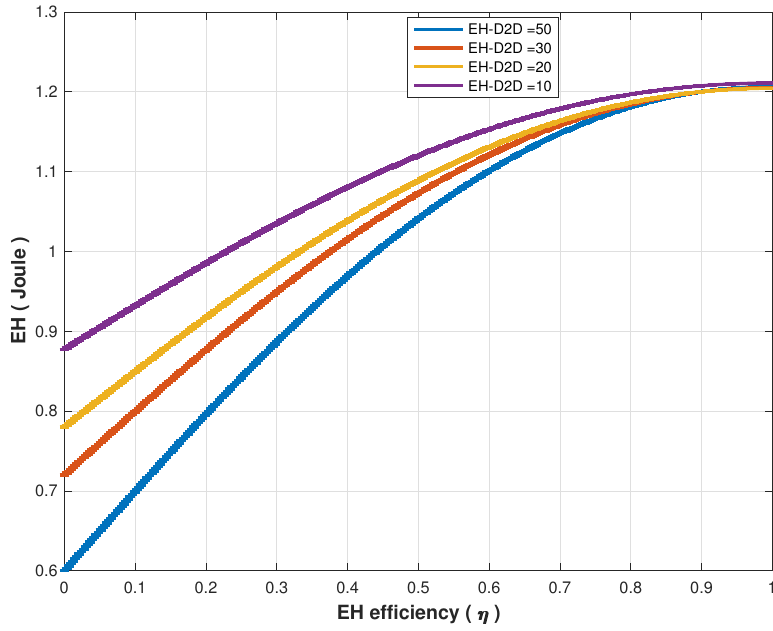
Figure 15. EH vs. energy harvesting efficiency ( η ) at different D2D